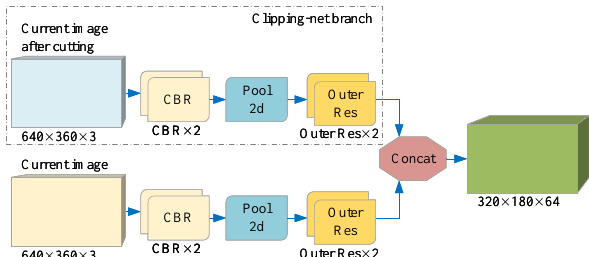
Figure 4. Per-pixel color features of two different data are extracted on two branches. Each branch is a CNN-based structure, which uses a continuous 3 × 3 convolution layer and residual network structure to map a color image of size W × H × 3 to a feature space of size W/2 × H/2 × C. Each element in the feature space is a C-dimensional vector representing the semantic information of the input image on the corresponding